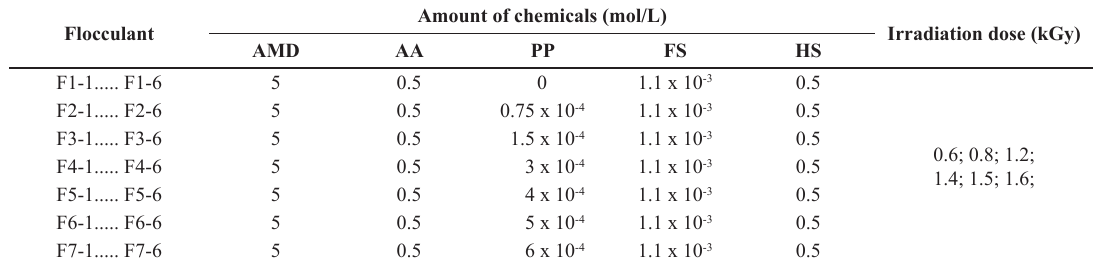
Table 1. Flocculants synthesis details.